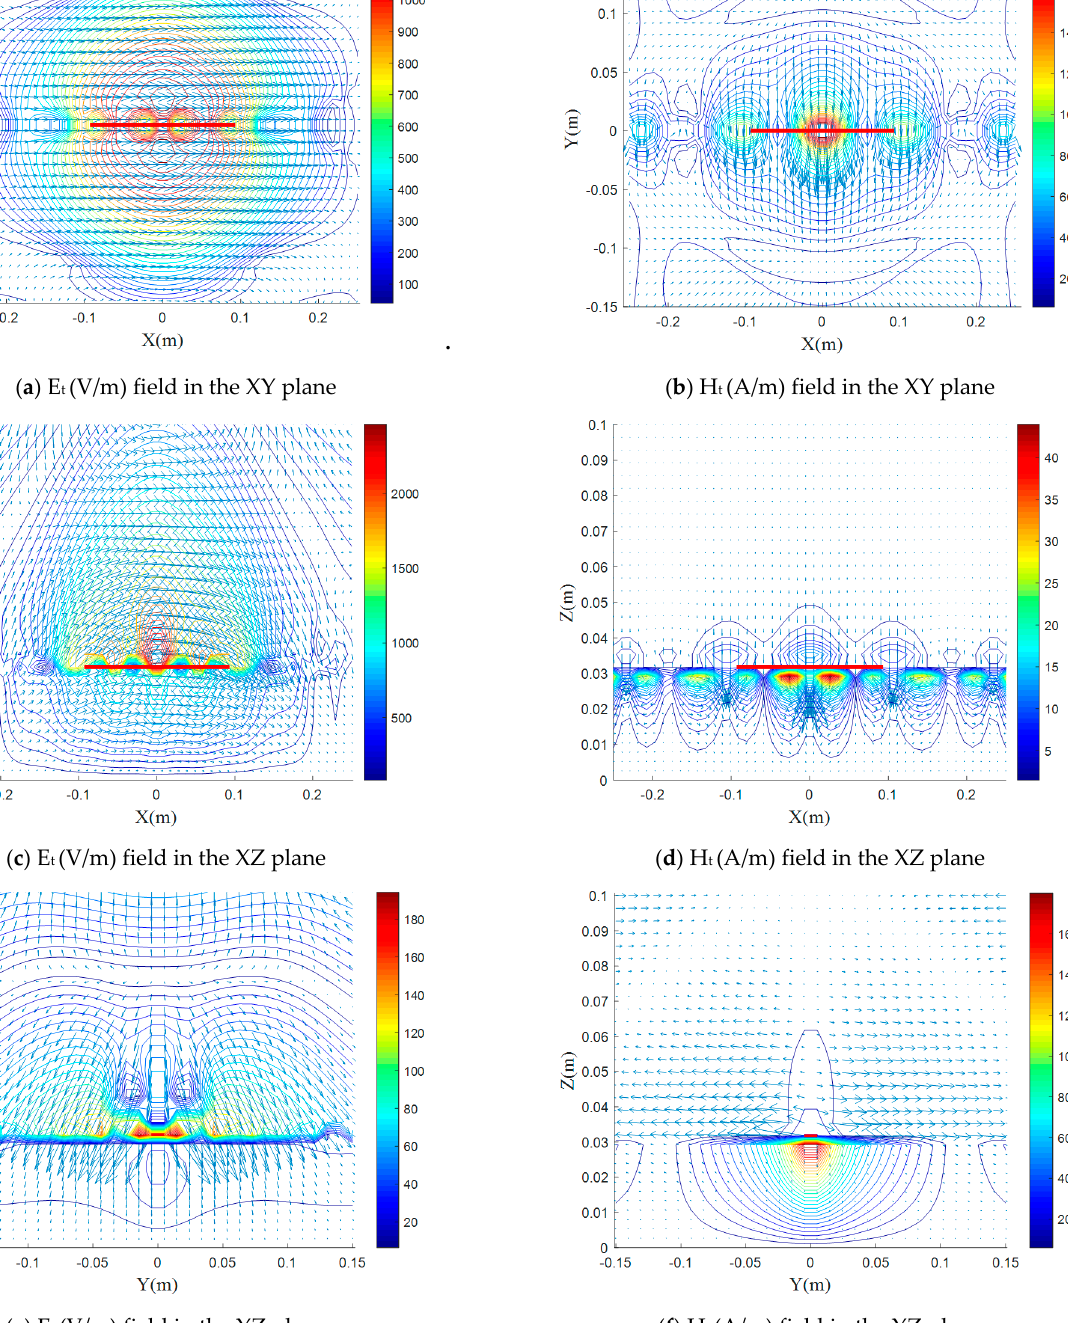
ε = ε = 3.25 and μ = μ = 1). t z t z